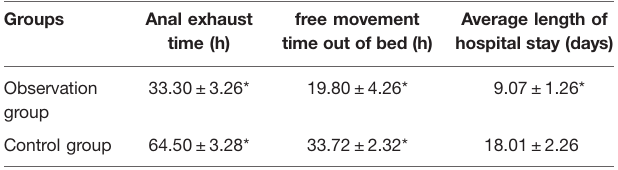
TABLE 2 | Comparison of therapeutic effects between two groups ( n =360, (cid:1) x + s ). Groups